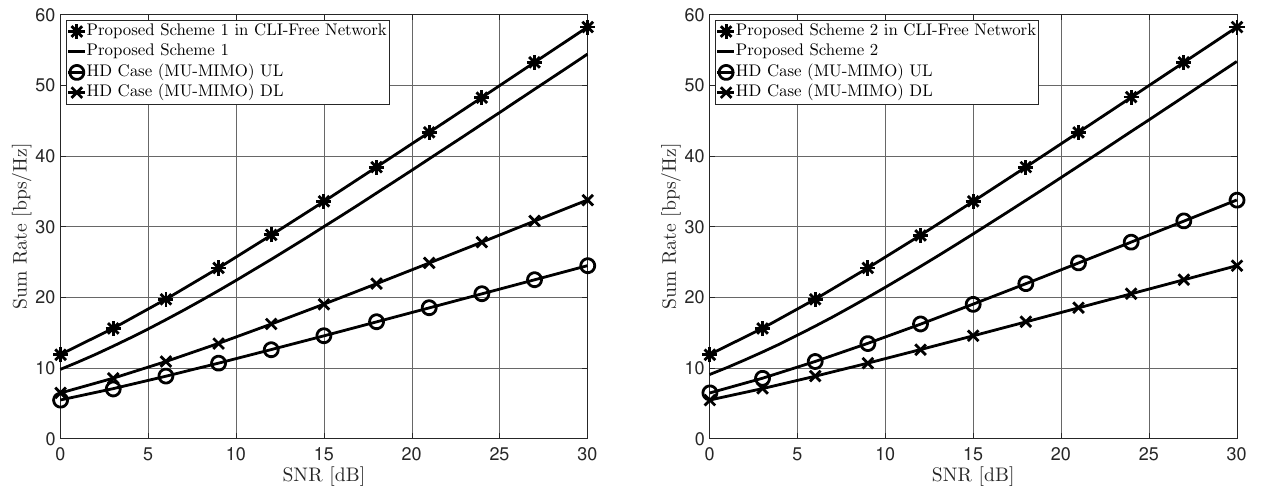
Proposed Scheme 1 in CLI-Free Network Proposed Scheme 1 HD Case (MU-MIMO) UL HD Case (MU-MIMO) DL